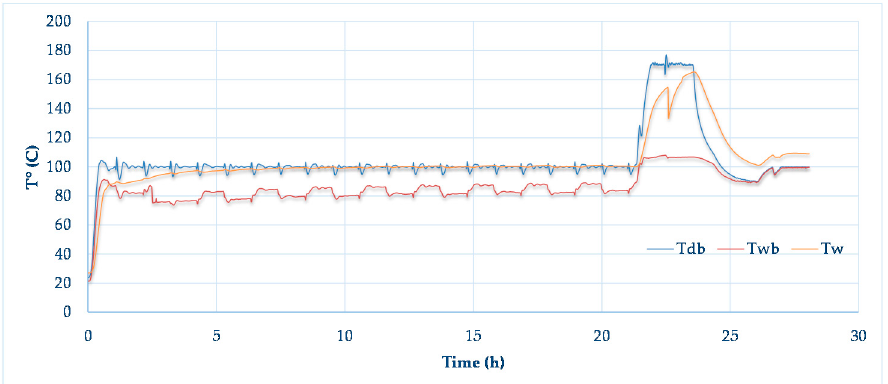
Figure 2. Evolution time of temperatures during the thermal modification process at 170 °C. Tdb— dry-bulb temperature; Twb—wet-bulb temperature; Tw—wood temperature.